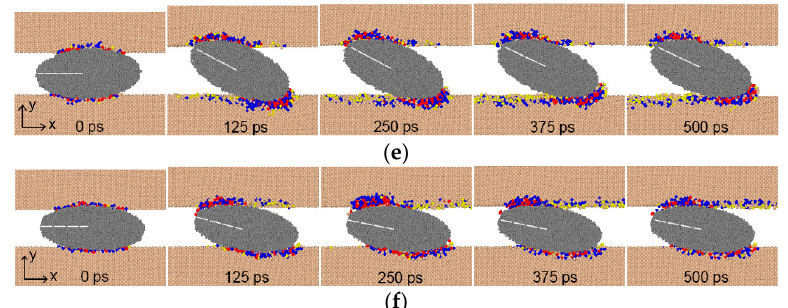
Figure 2. Atomic instantaneous configurations with different axial ratio ( a ) 1.00; ( b ) 0.80; ( c ) 0.60; ( d ) 0.48; ( e ) 0.45; and ( f ) 0.40. Atoms were colored according to the coordination number: tan, perfect diamond (Si-I) atoms; yellow, Si-III/Si-XII atoms; blue, Bct5 atoms; red, Si-II atoms.